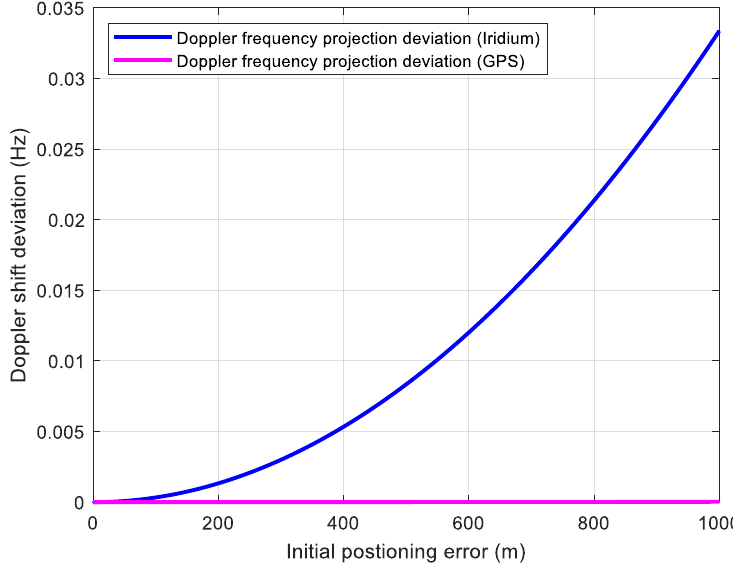
Figure 5. Doppler shift deviation caused by initial positioning error.